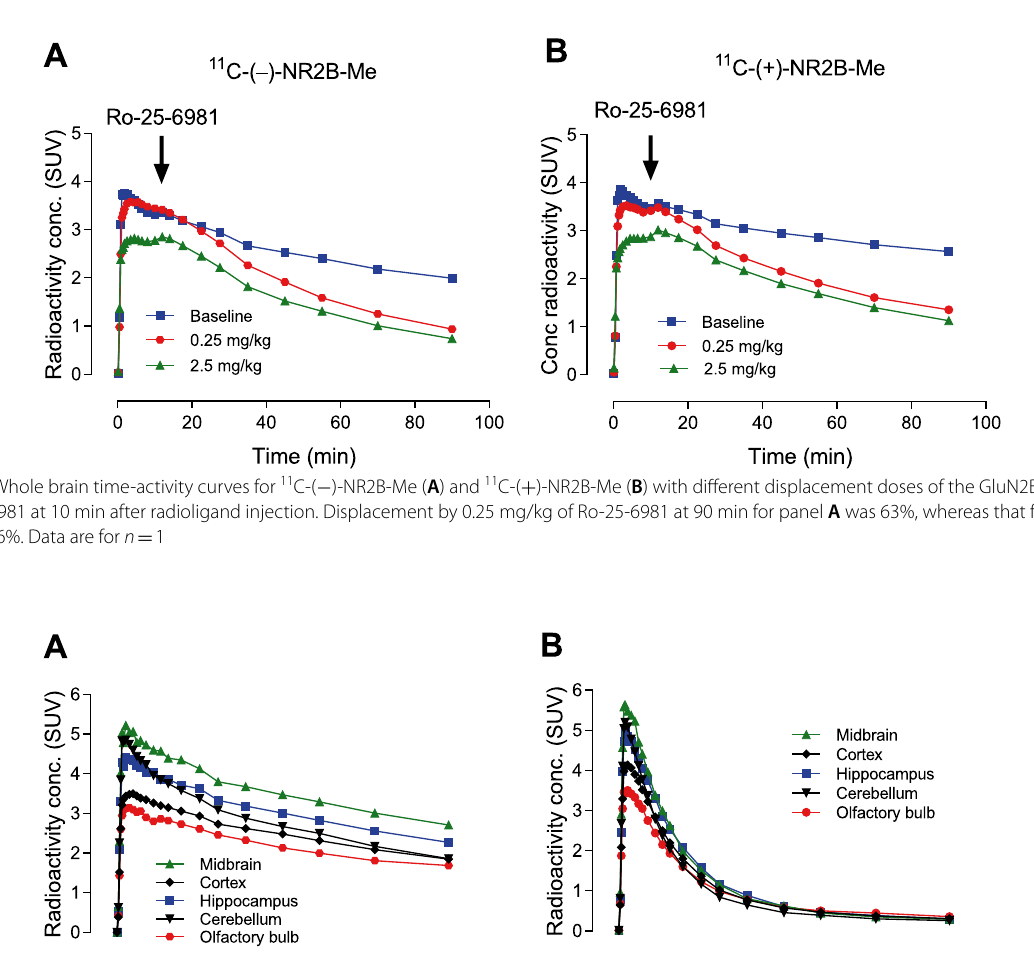
(Additional file 1: Table S1-S2, Additional file 1: Figure S8).